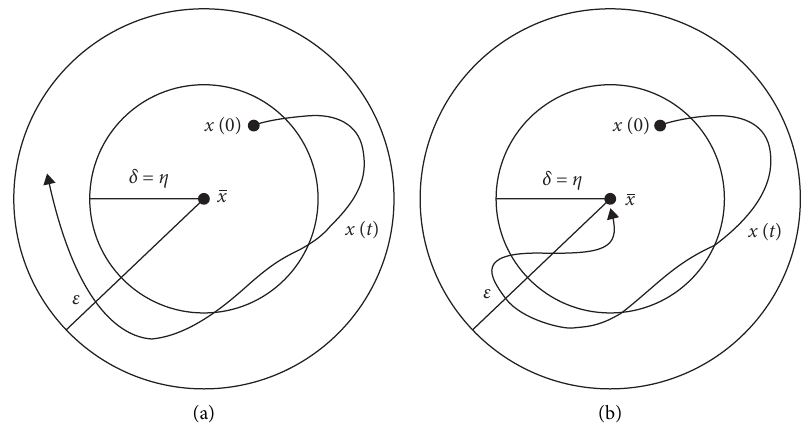
Figure 2: (a) Lyapunov stability and (b) asymptotic stability